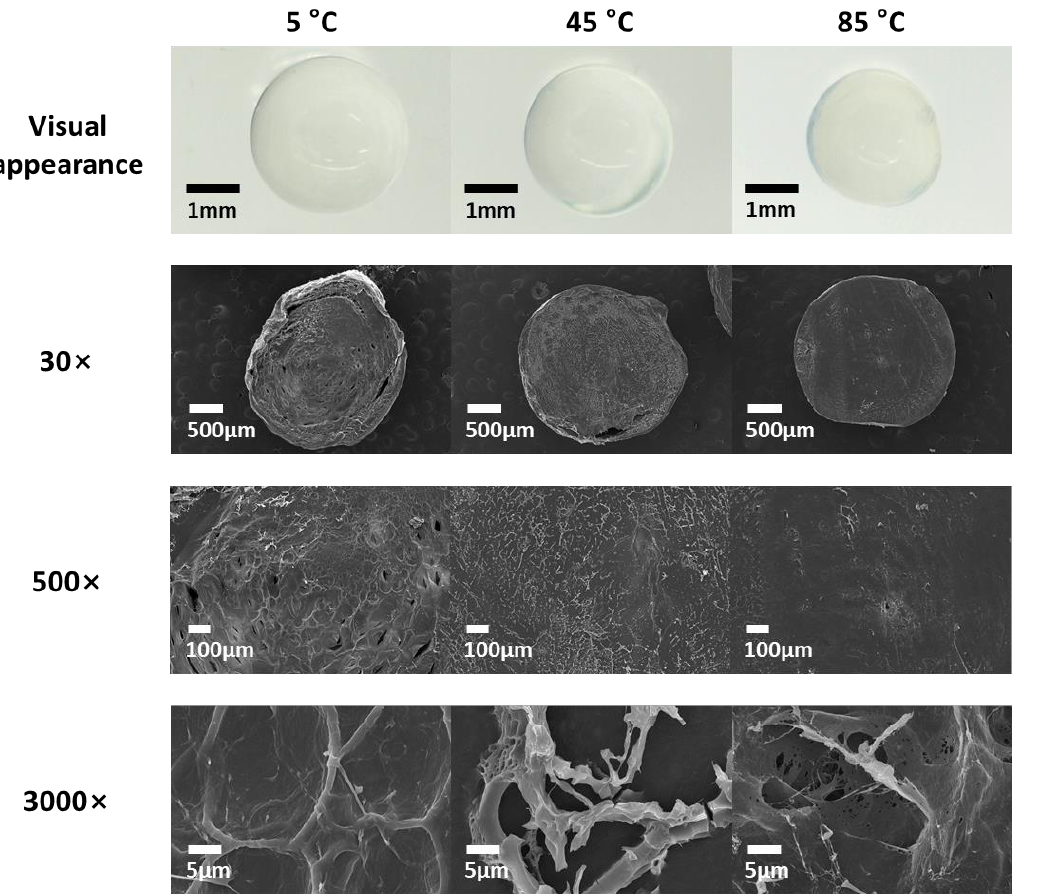
Figure 5. Visual appearance and low-vacuum scanning electron microscope (LV-SEM) images of CAG beads prepared at different gelation temperatures.